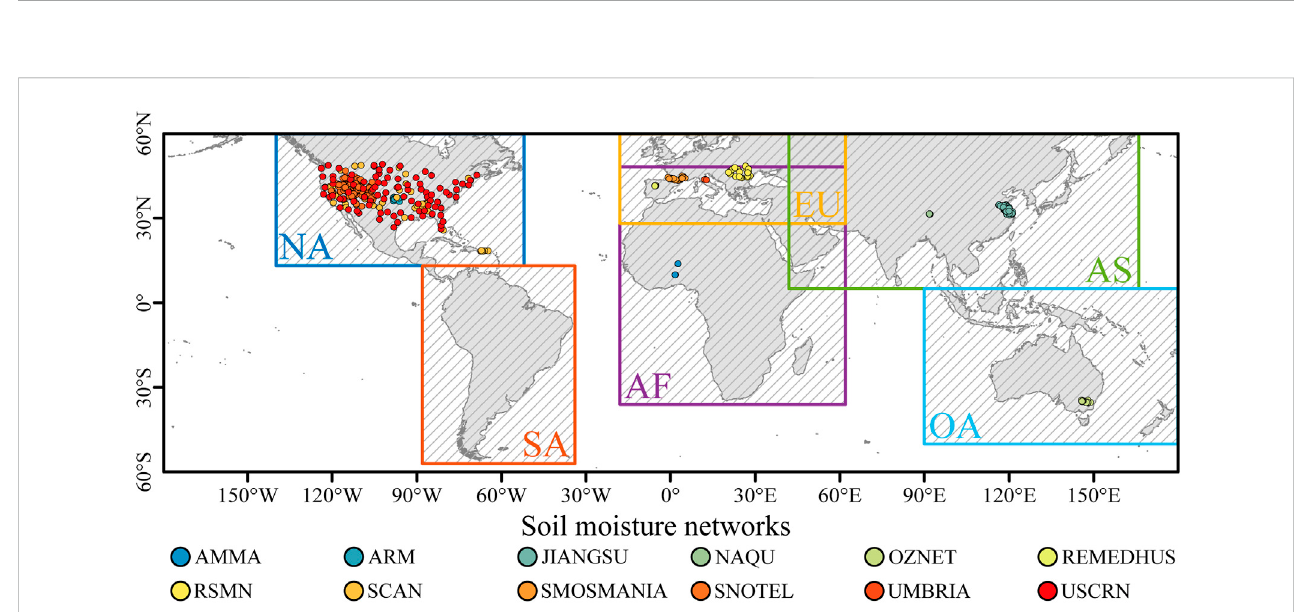
FIGURE 2 The partitioned regions for model training and the used 485 in-situ stations monitoring soil moisture. These stations are from 12 networks; JIANGSU network is from China and the other are from the ISMN project.